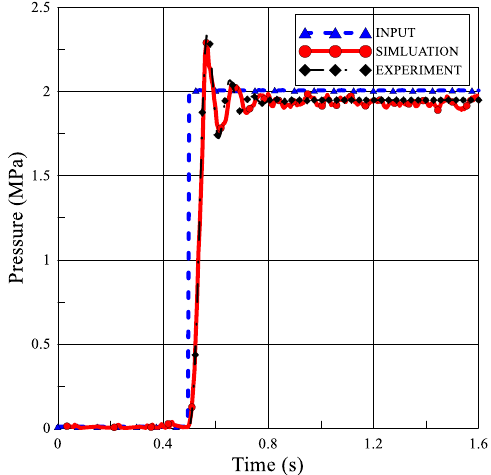
Figure 9. Step response characteristics of 2D digital buffer valve.